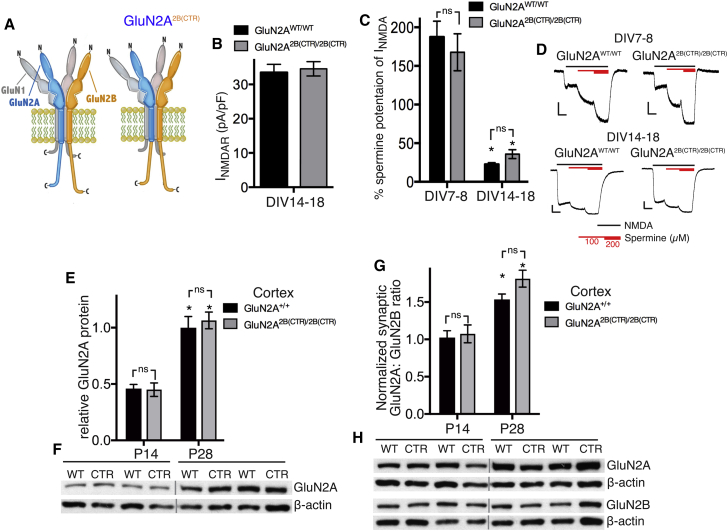
Distinct GluN2 CTDs Are Not Required for the 2B-to-2A Switch(A) Schematic illustrating the C-terminal domain exchange in the GluN2A2B(CTR)/2B(CTR) mouse.(B) NMDAR current density in GluN2AWT/WT (n = 30) and GluN2A2B(CTR)/2B(CTR) (n = 24) neurons, recorded DIV14–18.(C and D) Percentage potentiation of NMDAR currents by 100 μM spermine was measured in GluN2AWT/WT and GluN2A2B(CTR)/2B(CTR) neurons. ∗p < 0.05 versus DIV7 or DIV8 of the same genotype; two-way ANOVA plus Sidak’s post hoc test (GluN2AWT/WT: n = 19 [DIV7 or DIV8], n = 18 [DIV14–18]; GluN2A2B(CTR)/2B(CTR): n = 16 [DIV7 or DIV8], n = 17 [DIV14–18]). (C) shows quantitation of data and (D) shows example traces; scale bar: 200 pA/2 s.(E and F) Neocortical extracts from P14 and P28 mice of the indicated genotype were analyzed for GluN2A expression, normalized to β-actin. ∗p < 0.05 versus P14 of the same genotype; two-way ANOVA plus Sidak’s post hoc test (n = 8). (E) shows quantitation and (F) shows example blots.(G and H) PSD extracts from P14 and P28 mice of the indicated genotype were analyzed for GluN2A and GluN2B expression, normalized to β-actin, and the ratio calculated and scaled such that the ratio at P14 for WT = 1. ∗p < 0.05 versus P14 of the same genotype; two-way ANOVA plus Sidak’s post hoc test (n = 8). (G) shows quantitation and (H) shows an example blot.